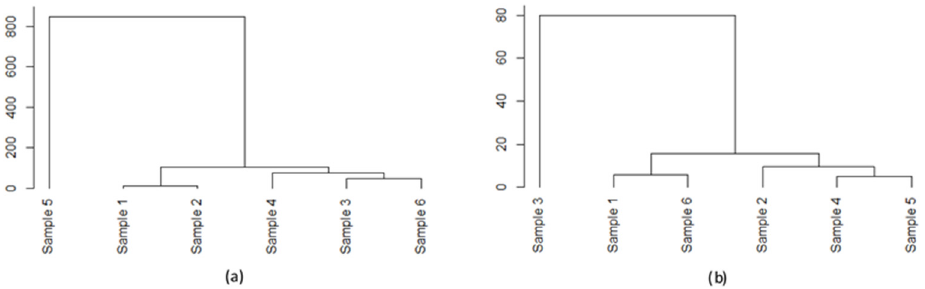
Figure 6. Dendrogram representing clustered toxic fingerprint based on heavy metal content of the six mushroom samples: In ( a ) dried samples and ( b ) water extracts.